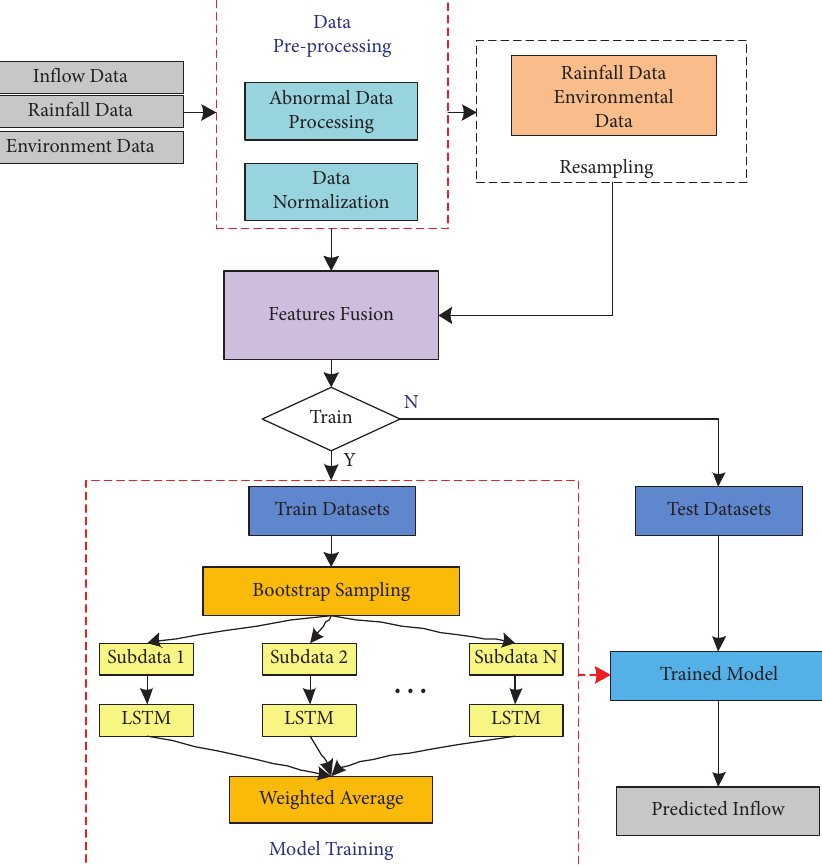
Figure 3: The flow chart of model